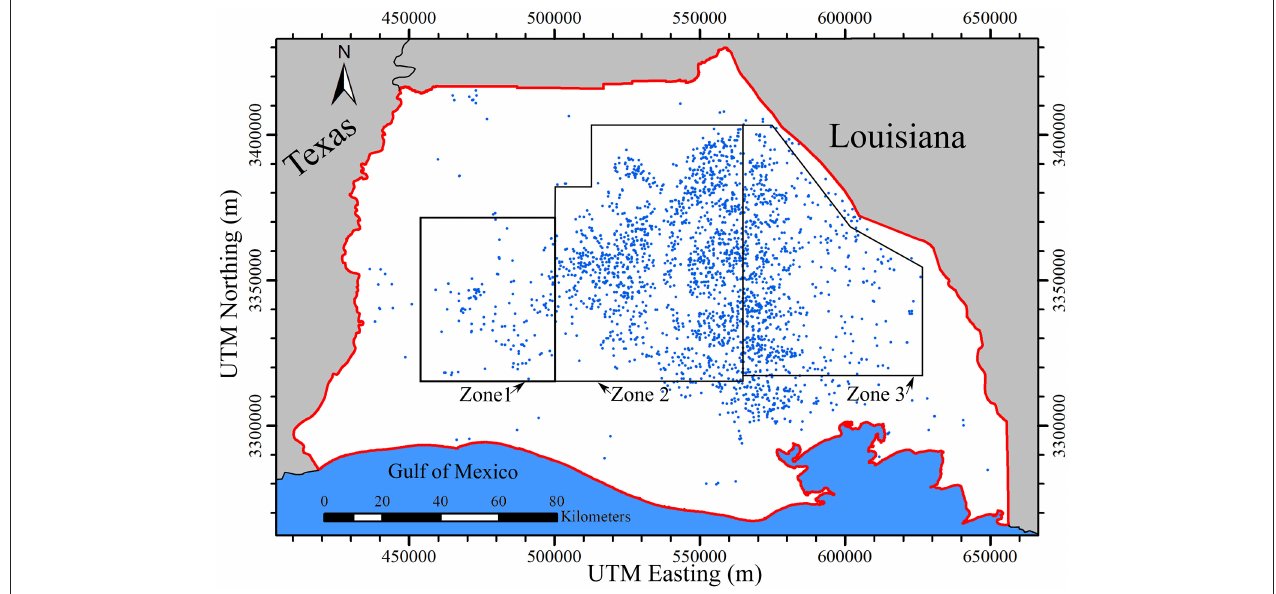
FIGURE 11 | Delineation of three zones, where Zone 1 includes the “200-foot” sand, the “500-foot” sand, and the “700-foot” sand, Zone 2 includes the Undifferentiated sand, and Zone 3 includes the Upper Chicot aquifer and Lower Chicot aquifer. Blue dots are pumping